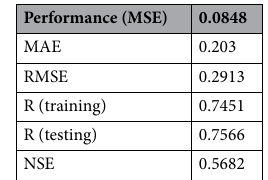
Table 2. Evaluation using LM backpropagation.